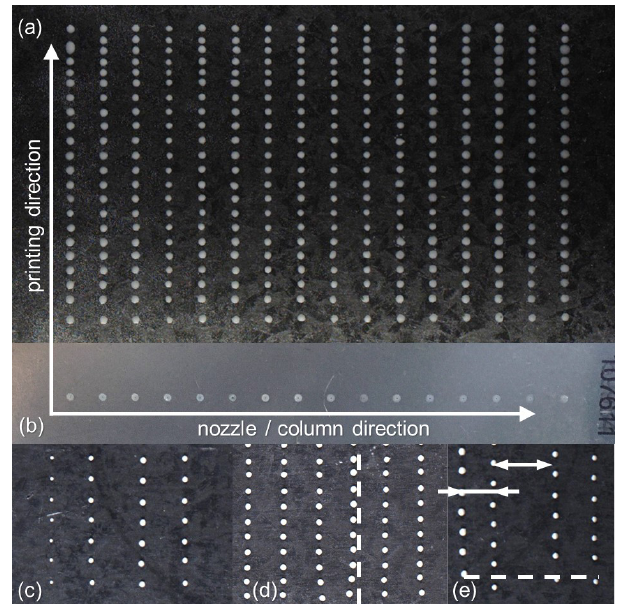
Figure 1. Printing failures caused by the solid particles in the ink impacting the printing quality in different ways: (a) Print with min- imum printing failures as reference. (b) Nozzle plate of the print- head with 16 nozzles, corresponding to the 16 columns in the test pattern. (c) Dot size varying from nozzle to nozzle. (d) The first printed dots (lower area of the image) deviate from their expected positions (indicated by the broken line). The deviation decreases as printing continues (towards the upper end of the image). (e) Con- stant deviation from expected dot position in vertical and horizontal